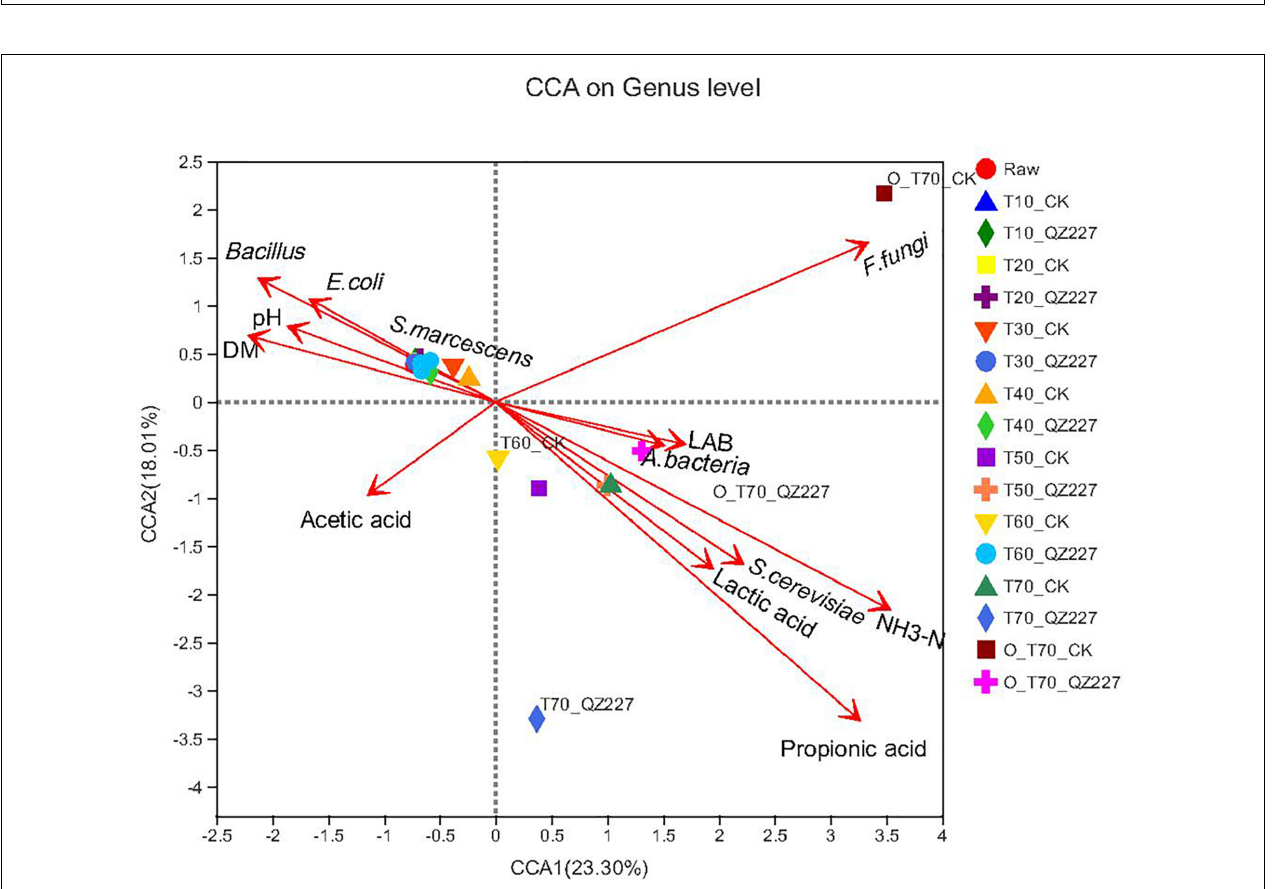
FIGURE 7 | Fungi CCA at the genus level. The dots in different colors or shapes represent the environment or condition sample groups.